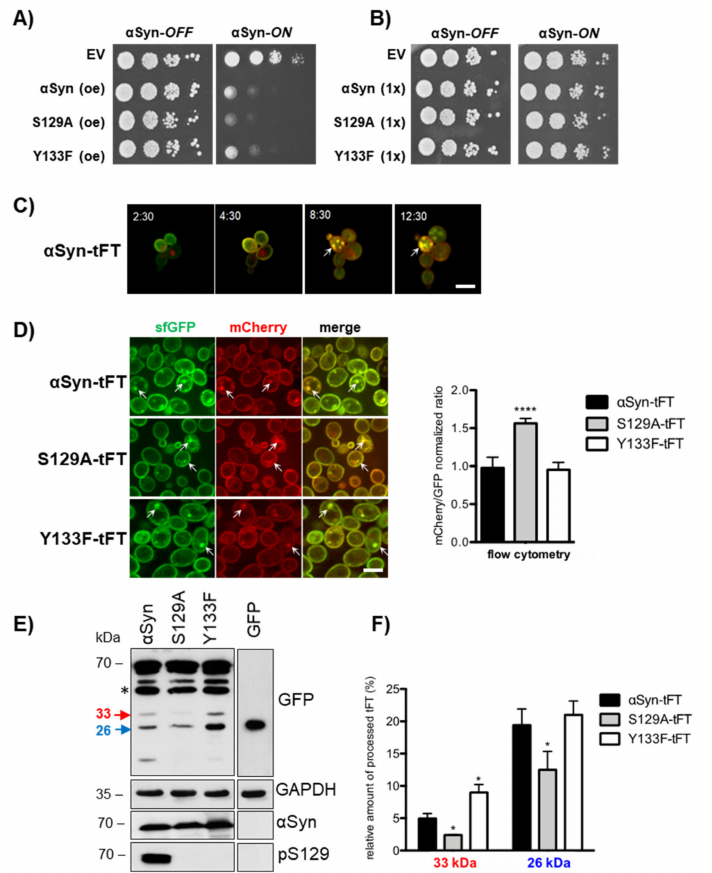
Figure 1. Phosphorylation at S129 promotes α Syn turnover. ( A ) Spotting test of yeast cells without ( α Syn-OFF) or with ( α Syn-ON) induction of GAL1 -driven α Syn-GFP, S129A-GFP or Y133-GFP expression from 2 µ plasmids (oe—overexpression). Empty vector (EV) was used as a control. ( B ) Spotting test of corresponding yeast cells, expressing only a single integrated gene copy (1 × ) of GAL1 -driven α Syn-tandem fluorescent timer (tFT), S129A-tFT, Y133-tFT or EV. ( C ) Fluorescence microscopy time series of yeast cells expressing single copy α Syn-tFT. The merge images show cells three-dimensionally trapped in a microfluidic device at the indicated time points after GAL1 promoter-mediated induction. Intracellular inclusions are marked with arrows. Scale bar = 5 µ m. ( D ) Fluorescence microscopy of strains expressing single-copy, tFT-tagged α Syn variants after 6 h induction of the GAL1 promoter (left panel). Intracellular inclusions are marked with arrows. Scale bar = 5 µ m. Fluorescence measurements with flow cytometry of the indicated strains (right panel). In total, 10,000 events were counted for each experiment. The significance of the differences was calculated with a t -test relative to α Syn-tFT (****, p < 0.0001, n = 6). ( E ) Western blot analysis of protein extracts from cells expressing single-copy, tFT-tagged α Syn variants or GFP as the control using GFP-antibody. The membrane was stripped and re-probed consecutively with α Syn antibody, S129 phosphorylation-specific α Syn antibody (pS129) or GAPDH antibody as the loading control. Only α Syn but no variant is phosphorylated at S129. The 33 kDa (red) fragment indicates proteasomal and the 26 kDa (blue) autophagy/vacuole-mediated degradation products. Asterisks indicate an mCherry ∆ N product resulting from mCherry hydrolysis during cell extract preparation [57]. ( F ) Densitometric analysis of the immunodetection of the specific tFT- α Syn degradation products. The relative intensity of the characteristic low molecular immunoblot bands was determined to examine the fate of the α Syn fusions. Band intensity relations within the same lane were quantified with ImageJ from anti-GFP immunoblot images. The relative amount of tFT degradation fragments to the total amount of loaded protein within one lane was calculated. The significance of the differences was determined with a t -test relative to α Syn (*, p < 0.05, n =